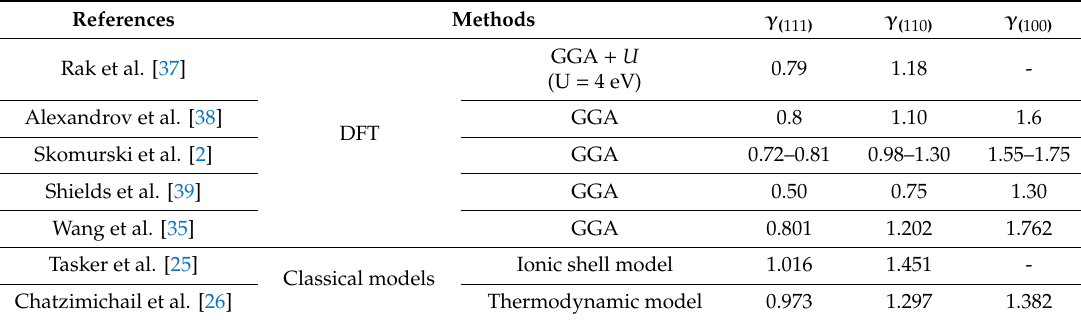
Table 1. ThO 2 surface energies in units of J/m 2 . DFT, density functional theory.